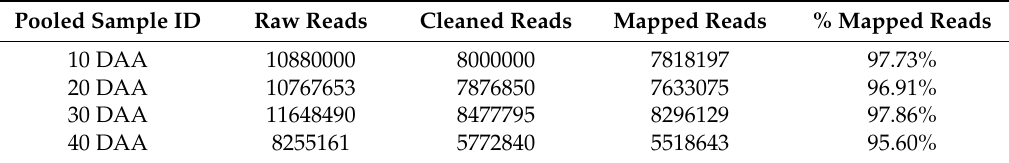
Table 2. Characterization of the constructed massive analysis of 3’-cDNA ends (MACE) libraries. Total raw, cleaned, and mapped reads of each sequenced sample on the Illumina Hiseq2000 are described. Percentage of mapped reads was calculated using the number of mapped reads/cleaned reads. DAA: days after